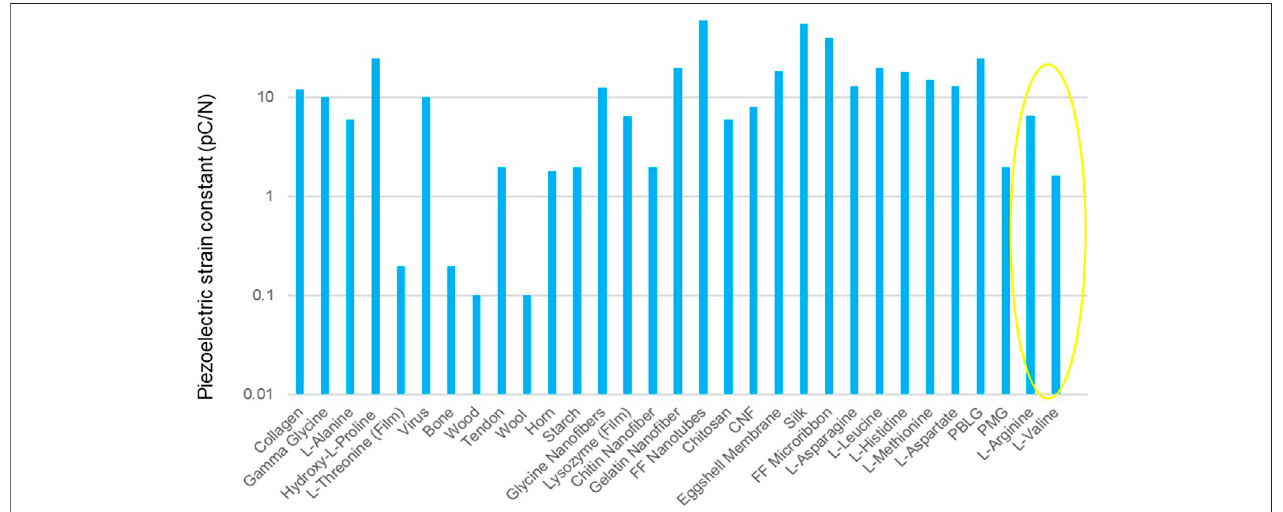
FIGURE 5 | Graph placing the piezoelectric charge constants of L-Arginine and L-Valine (circled in yellow) in the context of other biological materials.